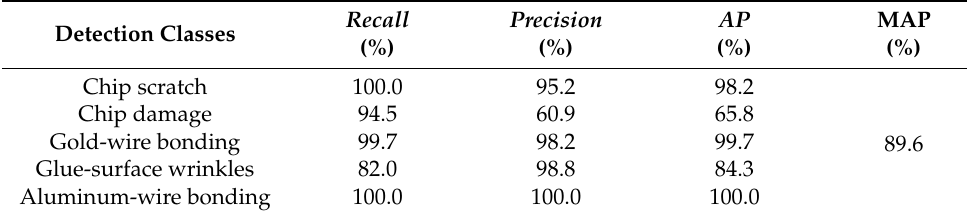
Table 1. Statistics of target-detection results without network